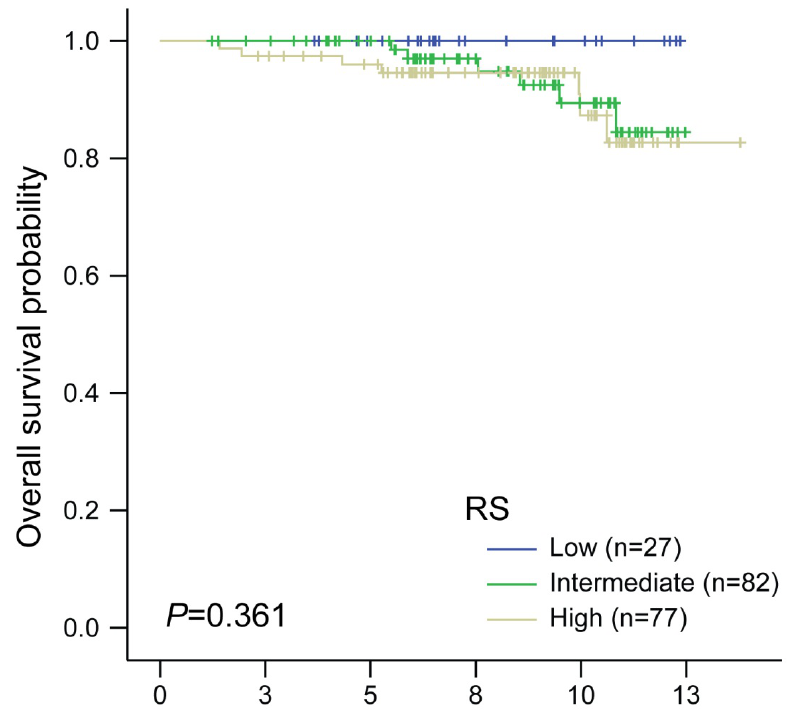
Figure 1. Kaplan-Meier plots for OS according to RS predictor in ER-positive patients ( p = 0.361, log-rank